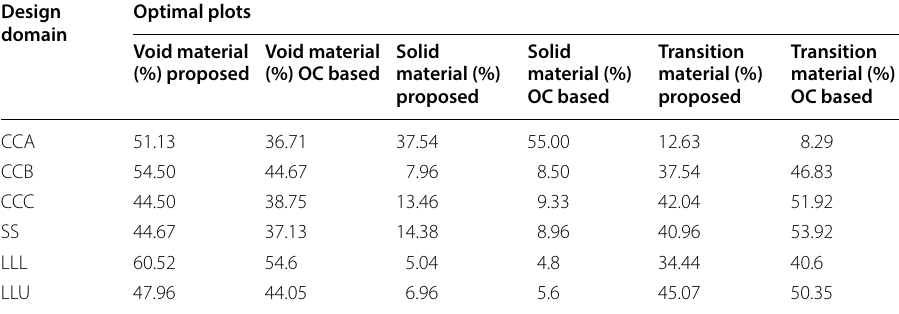
Where CCA, CCB, CCC, SS, LLL and LLU indicate classical cantilever beam, Cantilever beam with pre-defined shape, cantilever beam under multiple loading, simply supported beam and loading and boundary conditions of L-shaped beam,